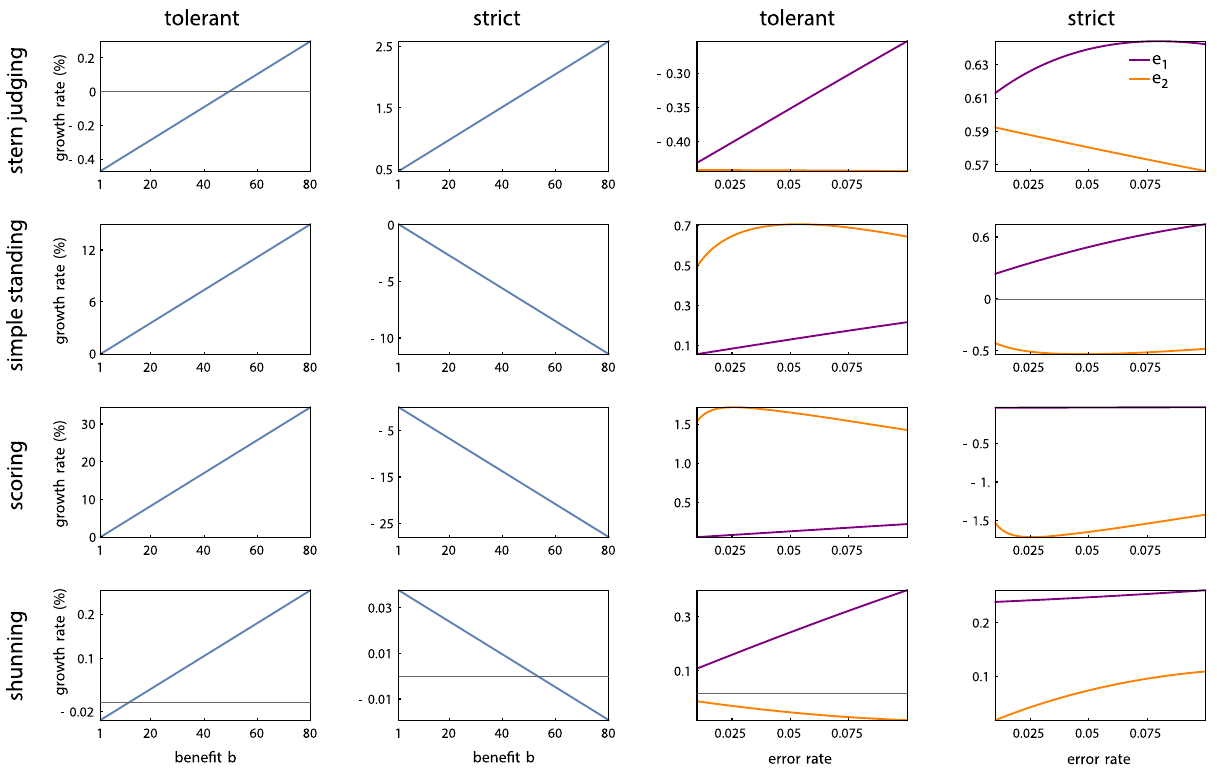
Fig. 5 Growth rate of institutional adherents (DISC-ADHERE) in a population otherwise composed of private assessors (DISC-PRIVATE). The instantaneous growth rate per unit time is computed according to replicator dynamics in an in fi nite population (Methods Eq. (11)) with the initial frequency of adherents set at 1/50, for strict ( q > 1/2) or tolerant ( q < 1/2) institutions of size Q = 2 (external board). Varying the bene fi t-to-cost ratio can have a qualitative impact on the evolution of institutional adherence. For example, under tolerant Stern Judging, adherents are strongly suppressed by selection for b / c < 50 but favored by selection for b / c > 50. Unless otherwise varied in a fi gure panel, parameter values are e 1 = e 2 = 0.02, b = 5, c =